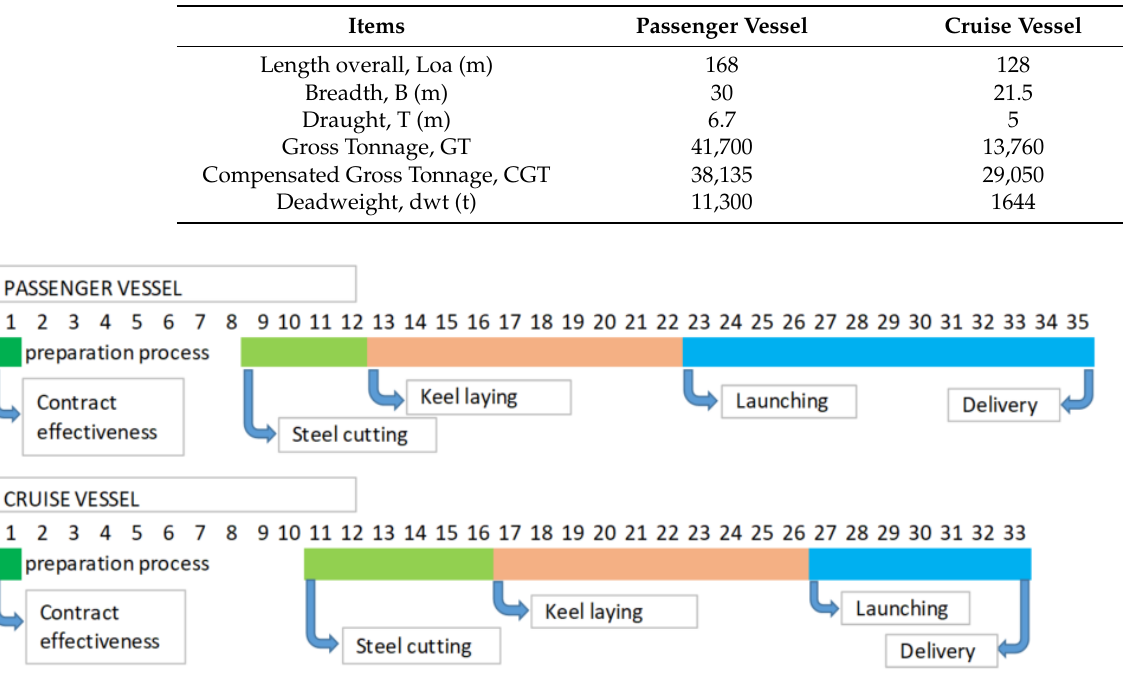
Figure 8. Shipbuilding duration in relation to the main events. Table 2. Outfitting stages — duration and ratio.